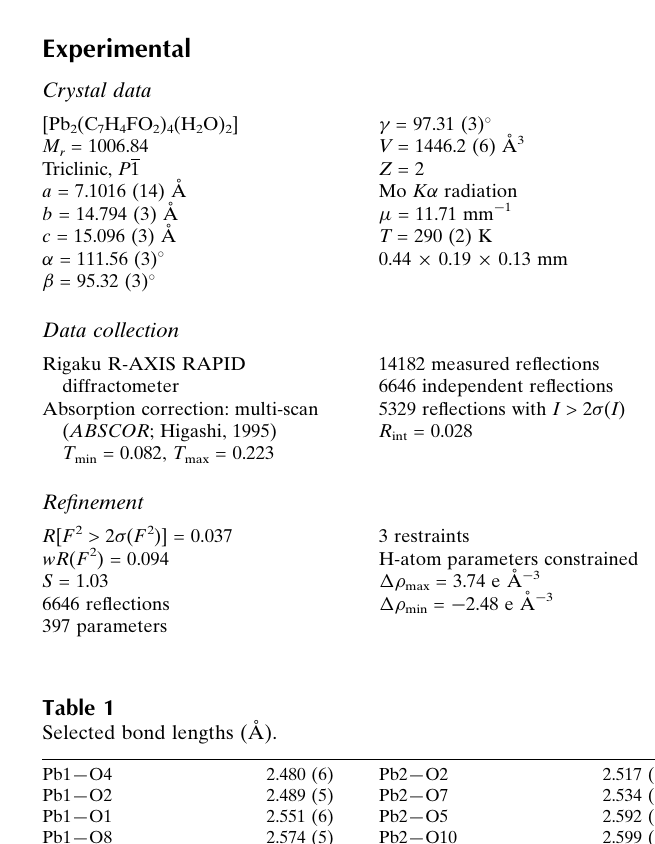
coordinated by five O atoms from four 2-fluorobenzoate ligands and three water molecules, resulting in distorted PbO F and PbO polyhedra. The 2-fluorobenzoate ligands 7 8